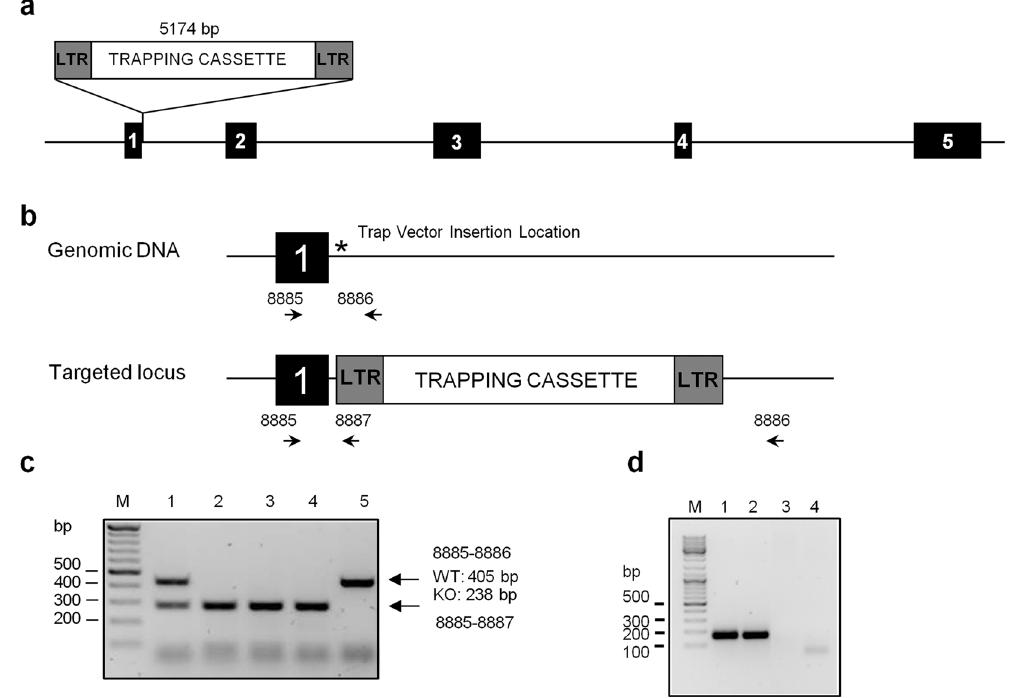
Figure 2. Targeted disruption of the murine Neil2 locus by gene trapping. ( a ) The Neil2 locus from the 129/ SvJ mouse genome is shown with indicated exons. A retroviral gene trap vector was used to produce a clone: OST218883, which contains an insertion within the first intron of Neil2 . This clone was used to generate Neil2 − / − mice. ( b ) Detail of the Neil2 locus from the 129/SvJ mouse genome and targeted Neil2 locus showing the position of the primers used for genotyping. ( c ) Typical genotyping results obtained by PCR after breeding Neil2 + / − mice with Neil2 + / − mice. ( d ) Disruption of Nei12 expression in Neil2 − / − mice was measured by RT- PCR analysis of mRNA isolated from brain and thymus. 1: WT brain, 2: WT thymus, 3: Neil2 − / − brain and 4: Nei12 − / − thymus. ( c and d) M: GeneRuler DNA ladder